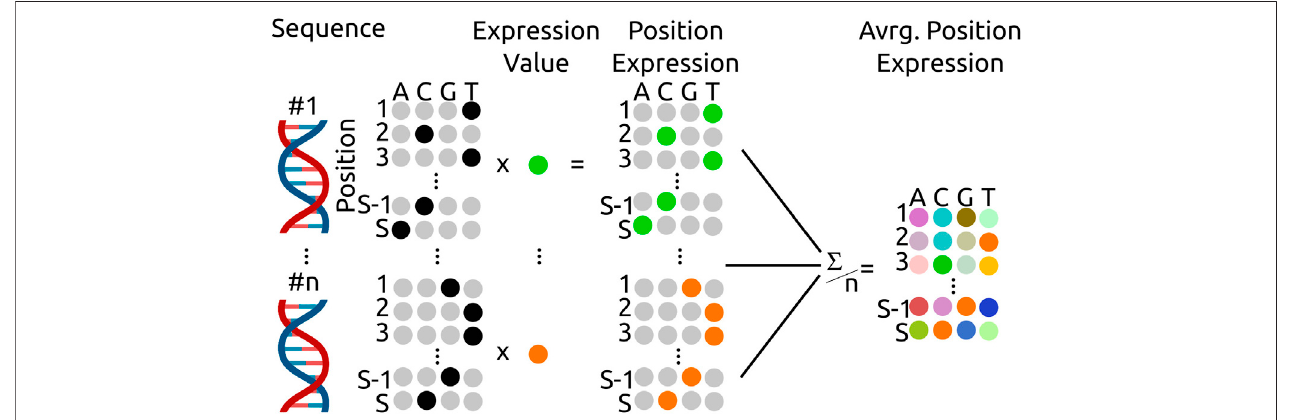
FIGURE 1 | Calculation scheme for the average, position dependent expression (cid:1) Exp . The one-hot encoding of each promoter sequence is multiplied by the sequence dependent expression strength to yield the position expression. The position expressions are summed and divided by the sample number to arrive at the average expression for each nucleotide at each